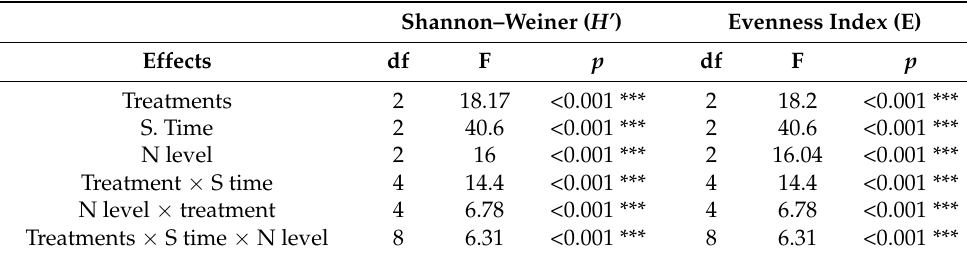
Table 7. The results of repeated ANOVA of the effect of tillage treatments, N fertiliser application rate, and sampling time on Shannon–Weiner and Evenness